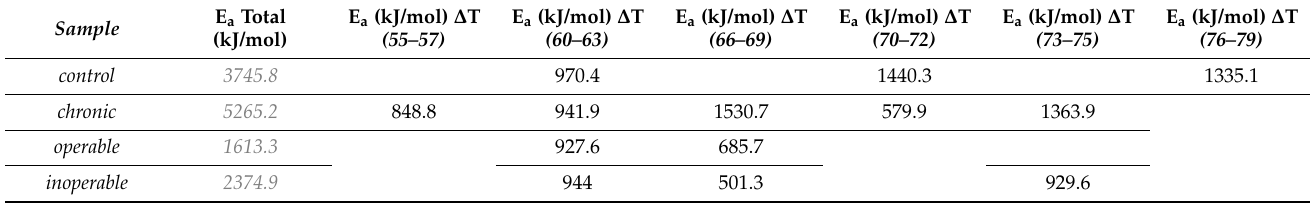
Table 6. Contribution of activation energies (gray numbers) resulted by the analysis of deconvolved data from Figure 3 regarding the different temperature ranges of the peaks ( ∆ T). (The empty fields indicating missing data as the fitting does not work properly with small peaks, thus cannot result applicable values, recently